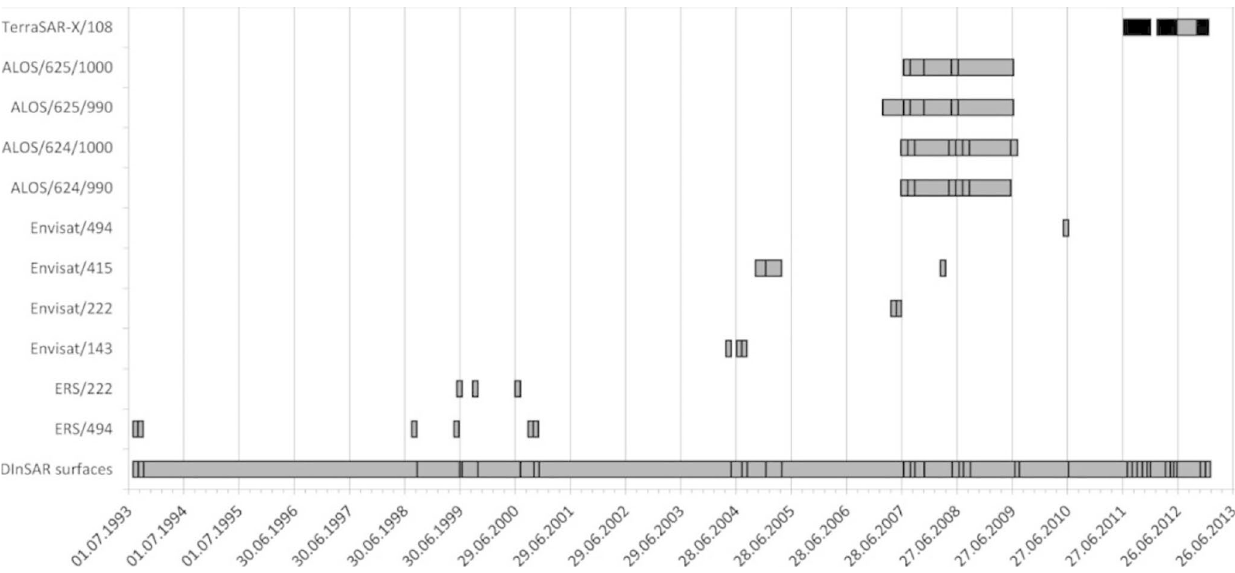
Fig. 2 Temporal cover of DInSAR interferograms used. Each horizontal line refers to the frame of SAR images used for interferograms creation. The lowest line named “DInSAR surfaces” refers to the images of subsidence over the whole USCB created based on